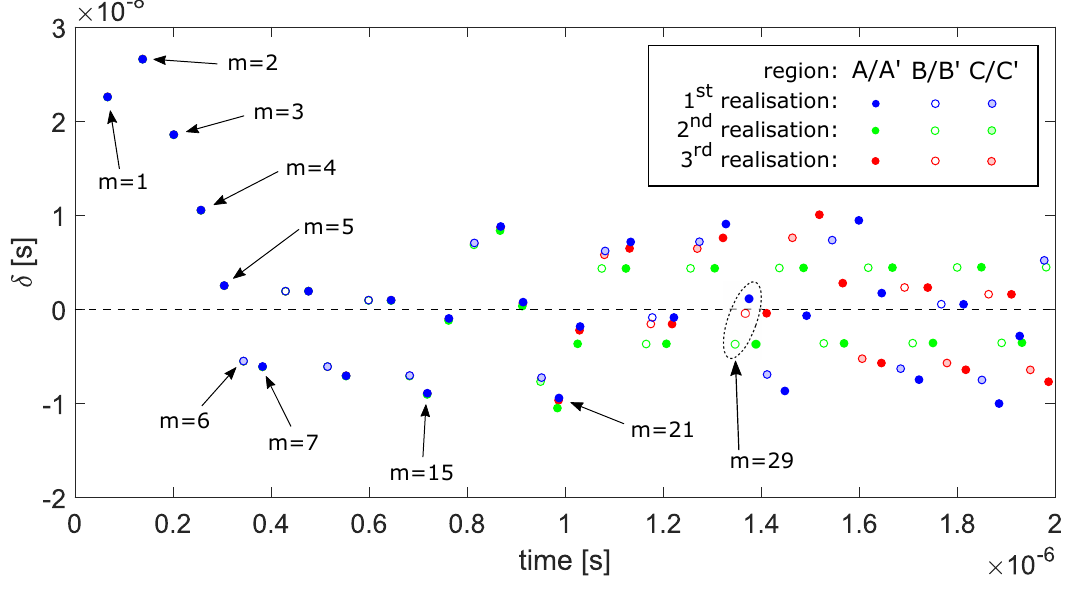
Figure 2. Deterministic chaotic δ [ m ] time series (in CPLD